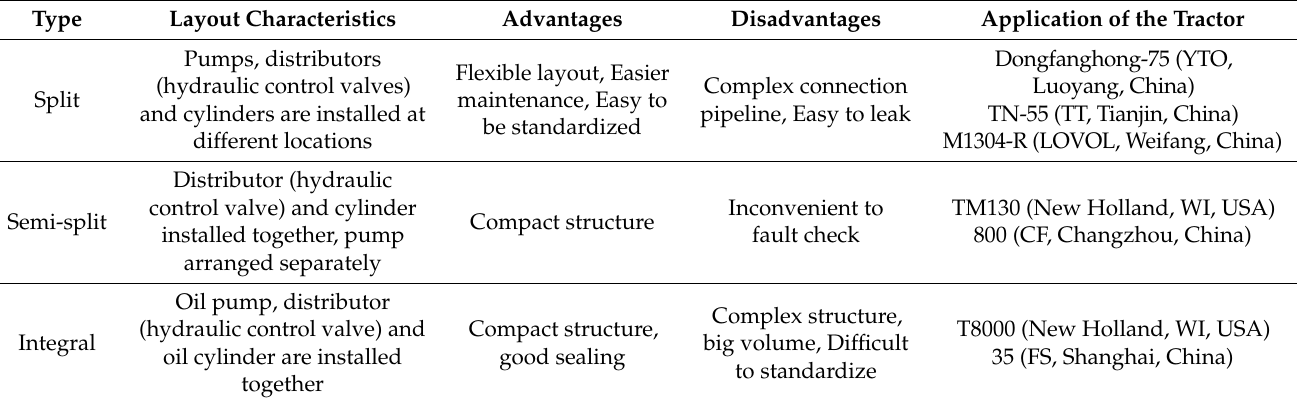
Table 1. Comparison of different hitch